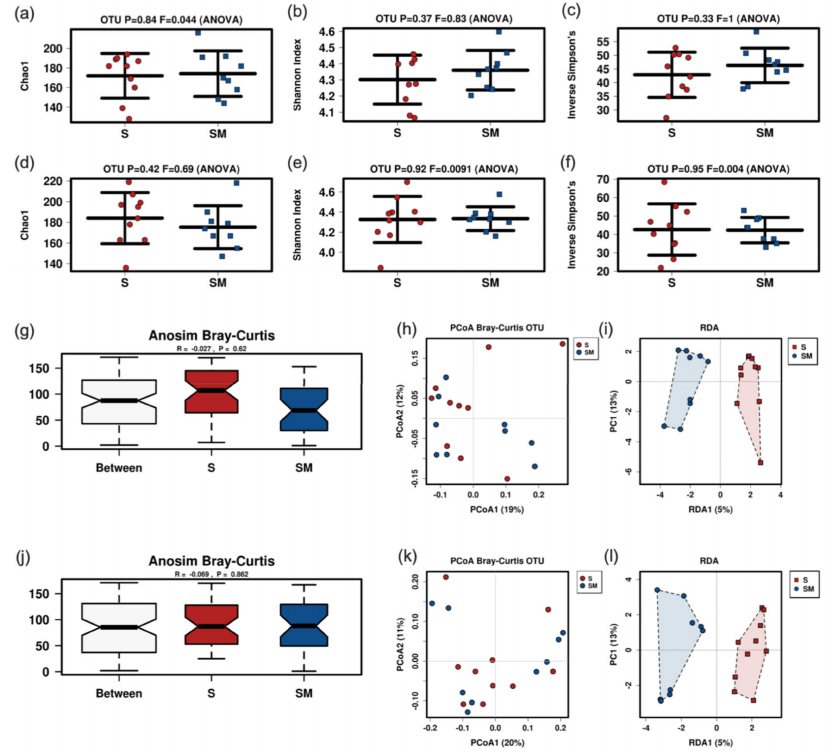
Figure 6. Results of murine fecal sample microbiome analysis after gavage of supernatant or control. Alpha diversity markers of supernatant harvested after 48 h (rarefication 14,420 reads) ( a – c ) or 196 h (rarefication 14,111 reads) culture time ( d – f ). Anosim Bray-Curtis and PCoA Bray Curtis plots for 48 h ( g , h ) and 196 h ( j , k ) supernatant. RDA for 48 h supernatant ( i ): p = 0.893; F 0.85; Var 18.34. RDA for 196 h supernatant ( l ): p = 0.699; F 0.92; var 19.3. S, supernatant; SM, medium